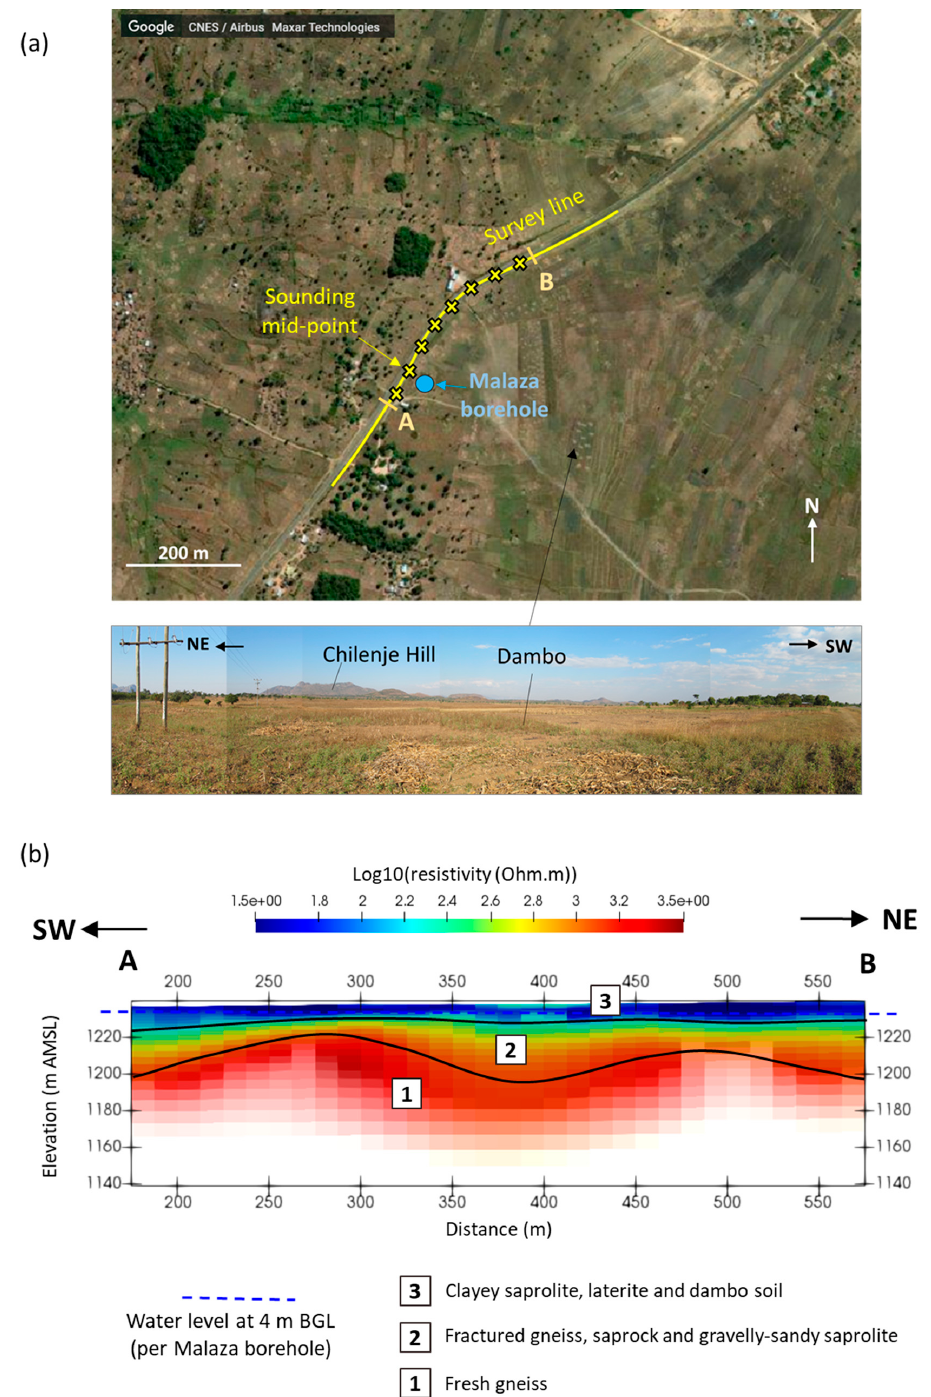
Figure 6. Malaza survey: ( a ) site survey line location (with individual sounding mid points marked as crosses) shown on a Google Earth satellite image (July 2020 download) of the area with accompanying landscape photograph; and, ( b ) interpreted subsurface resistivity cross-section obtain for section line AB marked on ( a ).